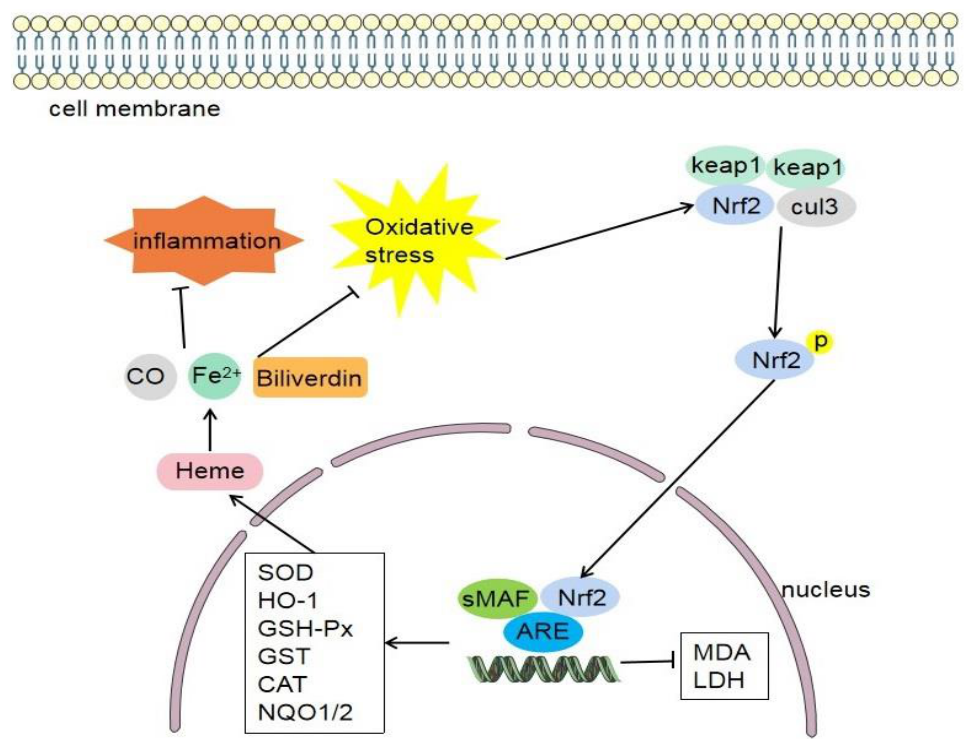
Figure 6. When oxidative stress occurs in the body, Nrf2 and Keap1 are dissociated and activated, transferred to the nucleus, Thereby promoting the activation of various target molecules (HO-1, SOD-1, GSH-Px, GST, CAT, NQO-1, NQO-2, etc.). Then, heme is further degraded into carbon monoxide (CO), biliverdin and iron ions (Fe 2+ ), and the oxidative stress and inflammatory reaction are feedback inhibited. Keap1, cytoplasmic kelch-like epichlorohydrin-associated protein 1; Nrf2, nuclear factor erythroid 2-related factor 2; sMAF, small musculoaponeurotic fibrosarcoma; ARE, antioxidant response element; cul3, cullin-3; HO-1, heme-oxygenase-1; NQO, quinine oxidoreductase; SOD, superoxide dismutase; GSH-Px, glutathione peroxidase; GST, glutathione S-transferase; CAT, catalase; MDA, malondialdehyde; LDH, lactate